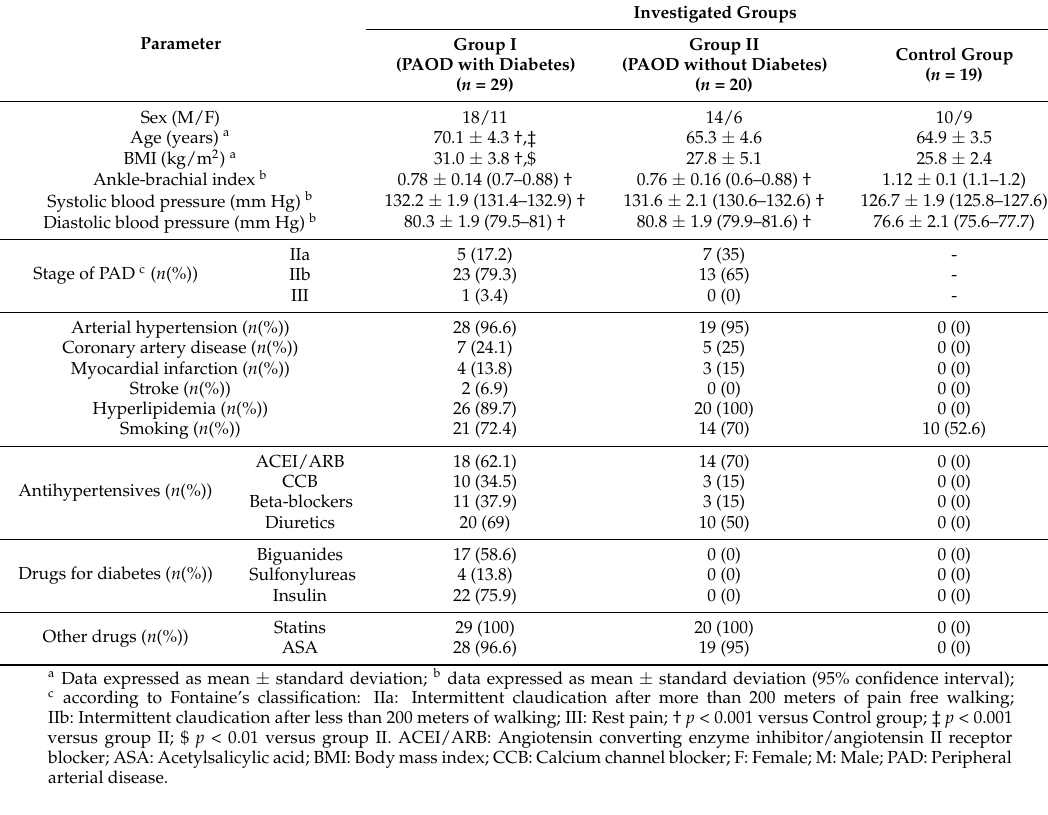
Table 1. Clinical parameters and ankle-brachial index (ABI) in patients with peripheral arterial occlusive disease (PAOD) of the lower extremities.